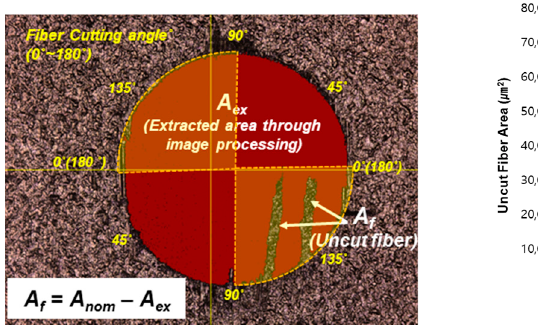
Figure 12. Images of the 28th drilled exit hole of MD-CFRP in each experimental case.